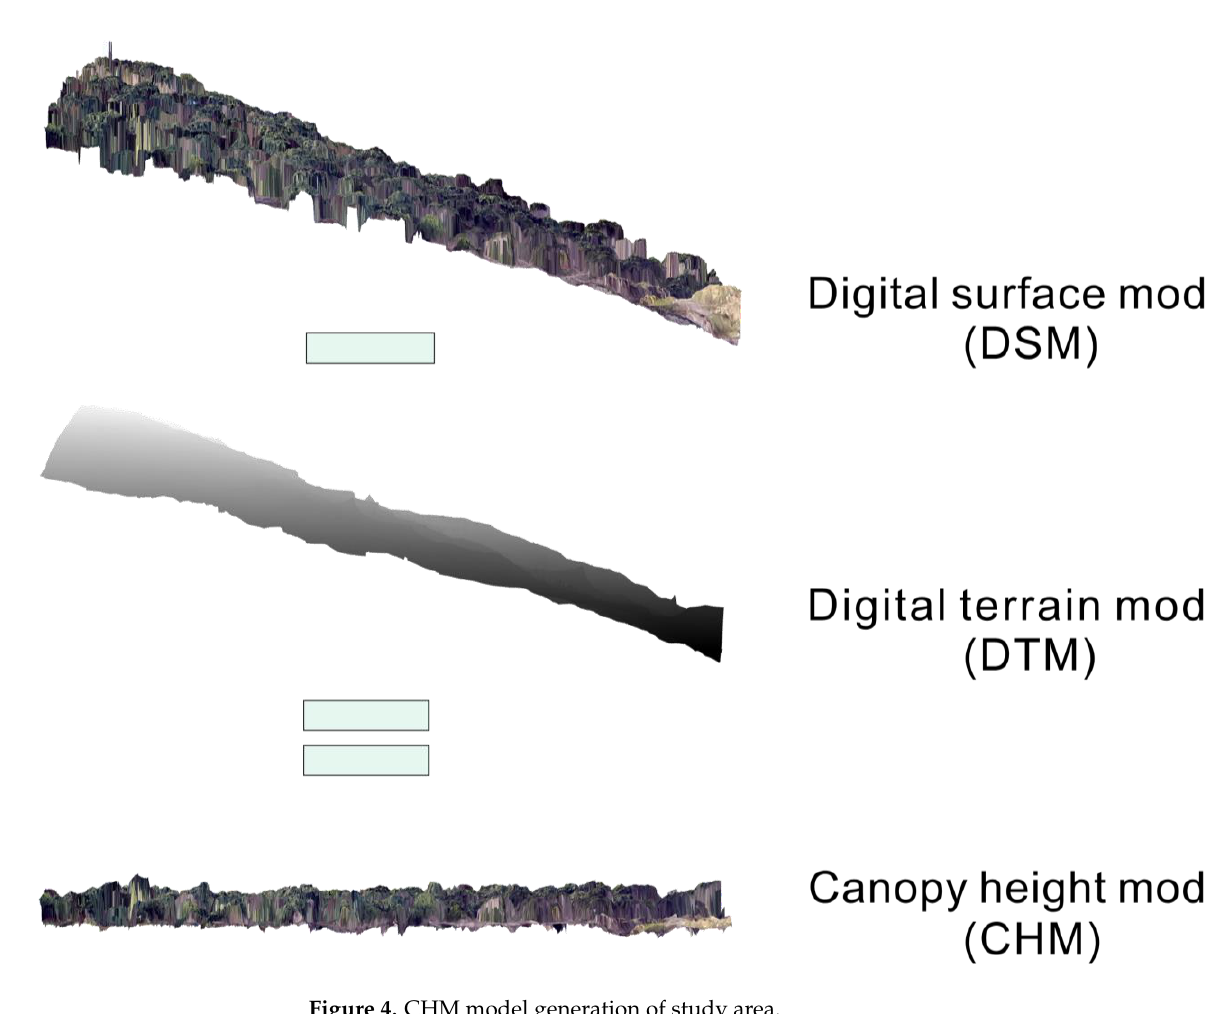
Figure 4. CHM model generation of study area.